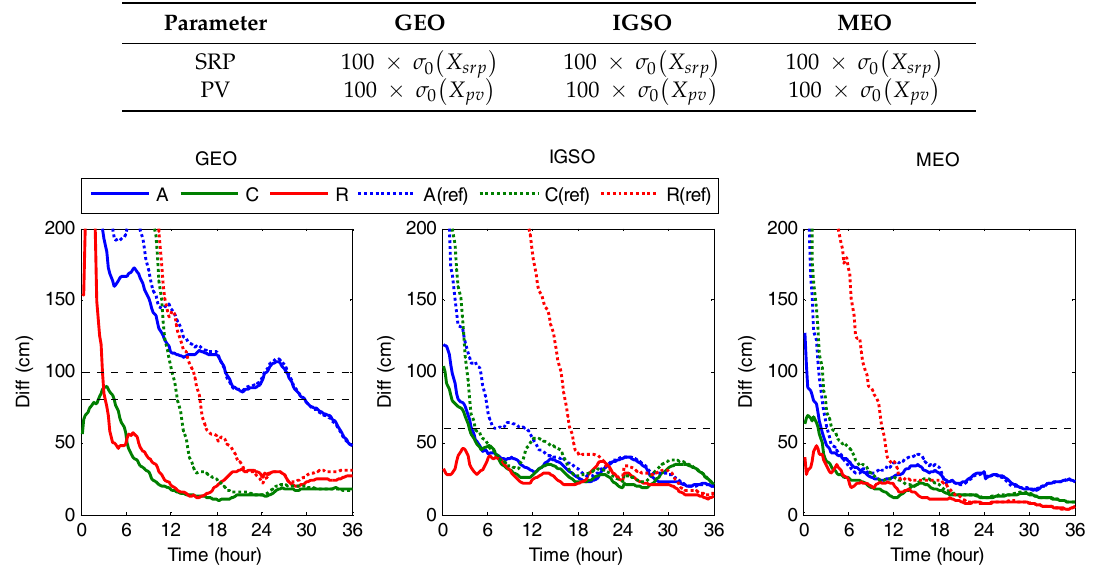
Figure 8. Time series of the average orbit accuracy using different a priori STD of SRP parameters. The BRDC product is used as the initial orbit. The horizontal black dotted line represents the convergence criteria for each direction. Table 9. The optimal a prior STD magnitude of SRP and PV parameters when the BRDC product is used as the initial orbit.